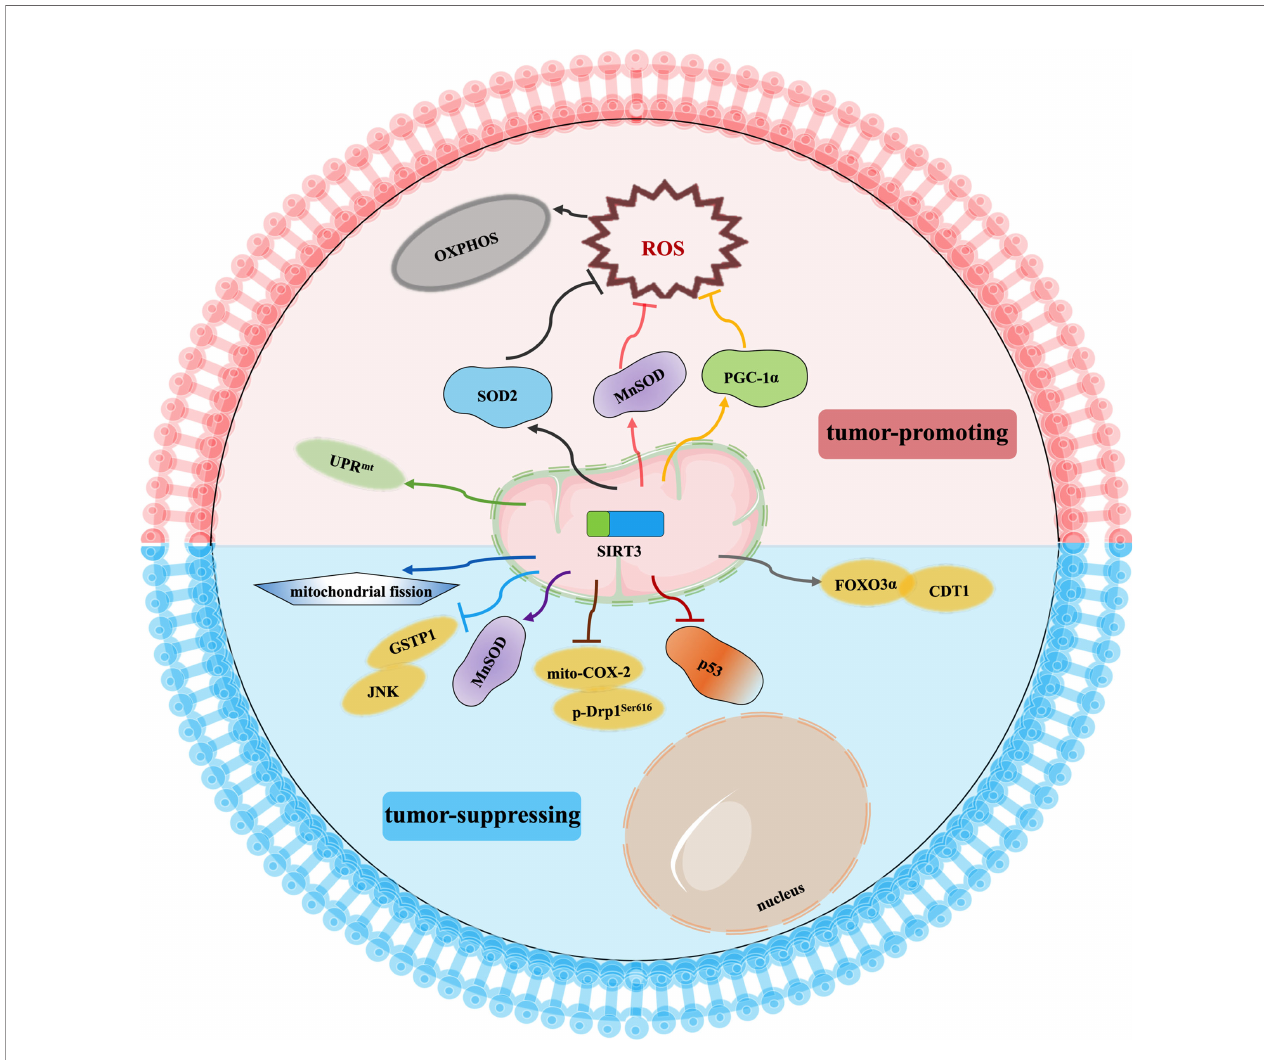
FIGURE 4 | Signaling functions of SIRT3 relevant to cancer chemoresistance. As a tumor-suppressing protein, SIRT3 not only deacetylates MnSOD and p53 but also regulates the mito-COX-2/p-Drp1 Ser616 pathway, SIRT3/GSTP1/JNK pathway, FOXO3 a /CDT1 pathway, and mitochondrial fi ssion to enhance chemotherapy drugs sensitivity of cancer. As a tumor-promoting protein, SIRT3 scavenges the oxidant products by deacetylating SOD2, MnSOD, and PGC-1 a , and activates UPR mt to promote chemotherapy drugs resistance